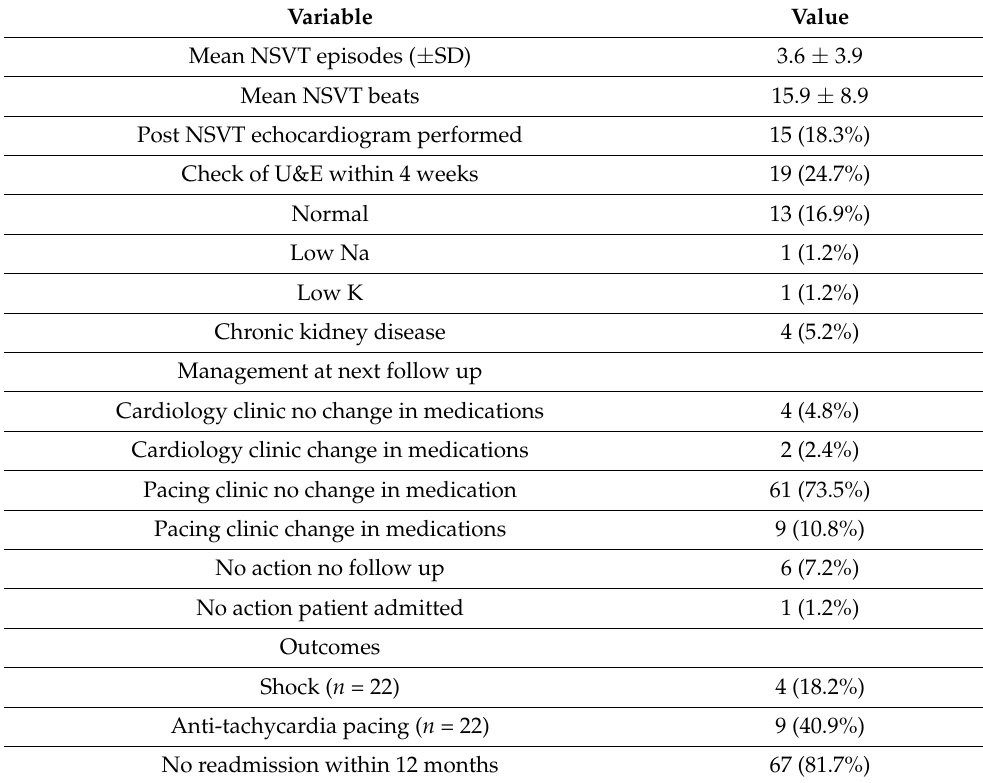
Table 3. Non-sustained ventricular tachycardia event, management and